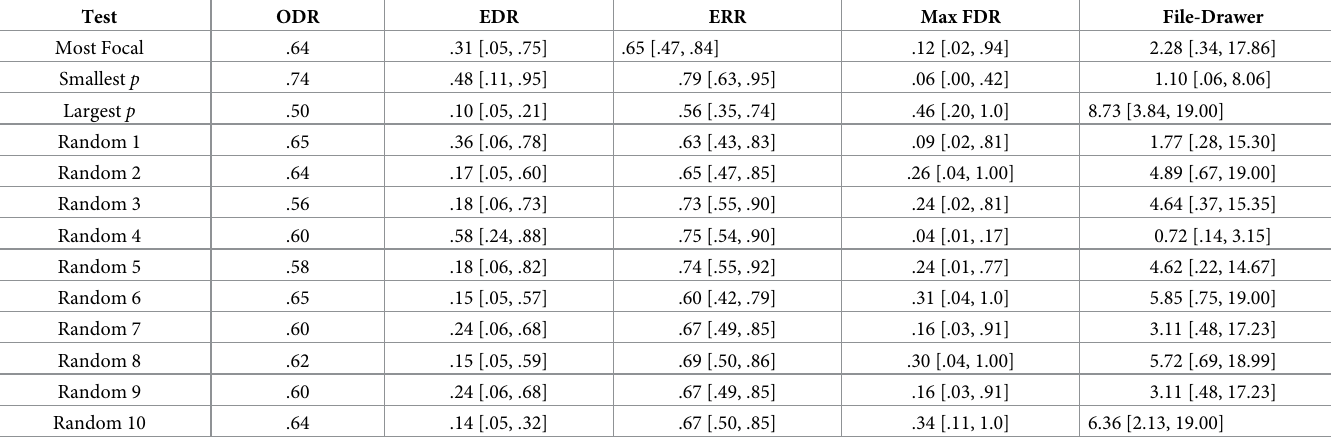
Table 3. Z-curve estimates and 95% confidence